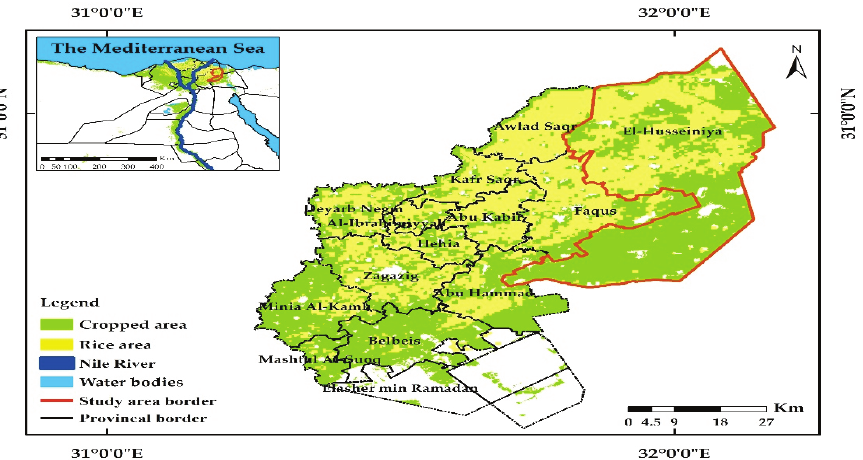
Figure 1. Geographic locations and distribution of rice cultivation regions over the study area at a 10 m resolution. 10 m